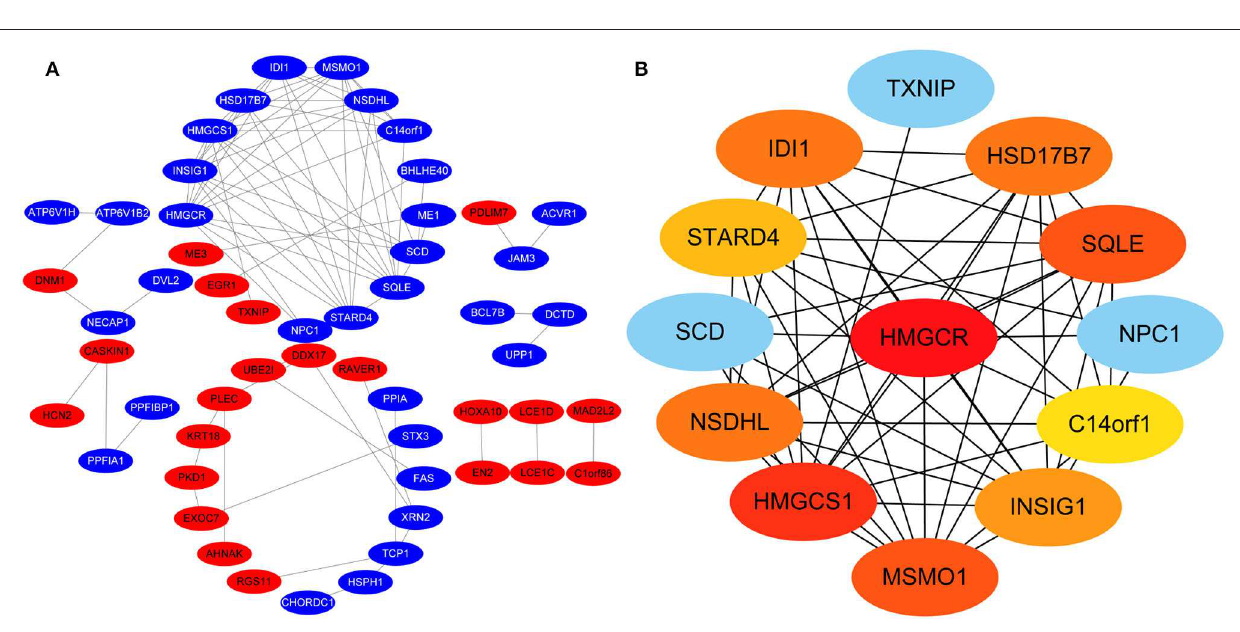
FIGURE 6 | PPI network at 24h. (A) Entire network. Downregulated and upregulated genes are represented by red and blue backgrounds, respectively. (B) Subnetwork for the top 10 hub genes and neighbors. The backgrounds of hub genes are colored from red to yellow by rank, and the backgrounds of neighboring genes are light blue. PPI, protein-protein